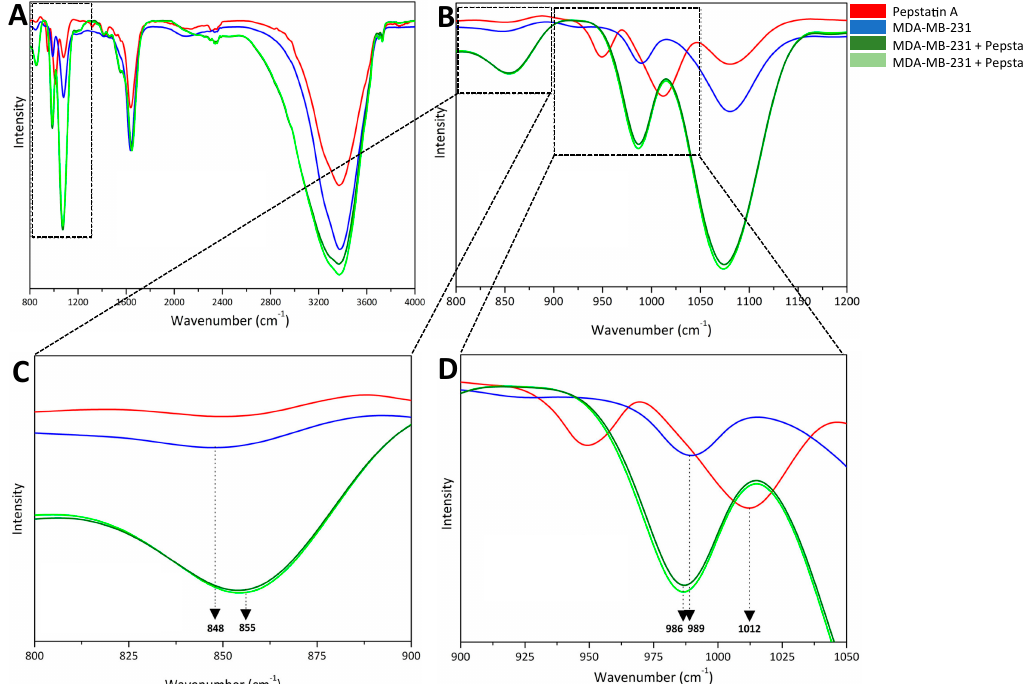
Figure 2. FTIR spectroscopy analysis of atoms involved in CatD inhibition. ( A ) Fourier transform infrared spectroscopy spectra of PepA (red), cells (blue), and cells treated with PepA (1 µ M, light green; 10 µ M, dark green) at a range of 800–4000 cm − 1 . For better visualization, spectra are zoomed in on the following ranges: ( B ) 800–1200 cm − 1 , ( C ) 800–900 cm − 1 with dominant bands from OH bending vibration at 848 cm − 1 and CO bending vibration at 855 cm − 1 , both from carboxylic acid from CatD aspartates; and ( D ) 900–1050 cm − 1 with dominant bands at 986 cm − 1 and 989 cm − 1 from OH bending vibration and 1012 cm − 1 from OH angular deformation from PepA molecule structure.